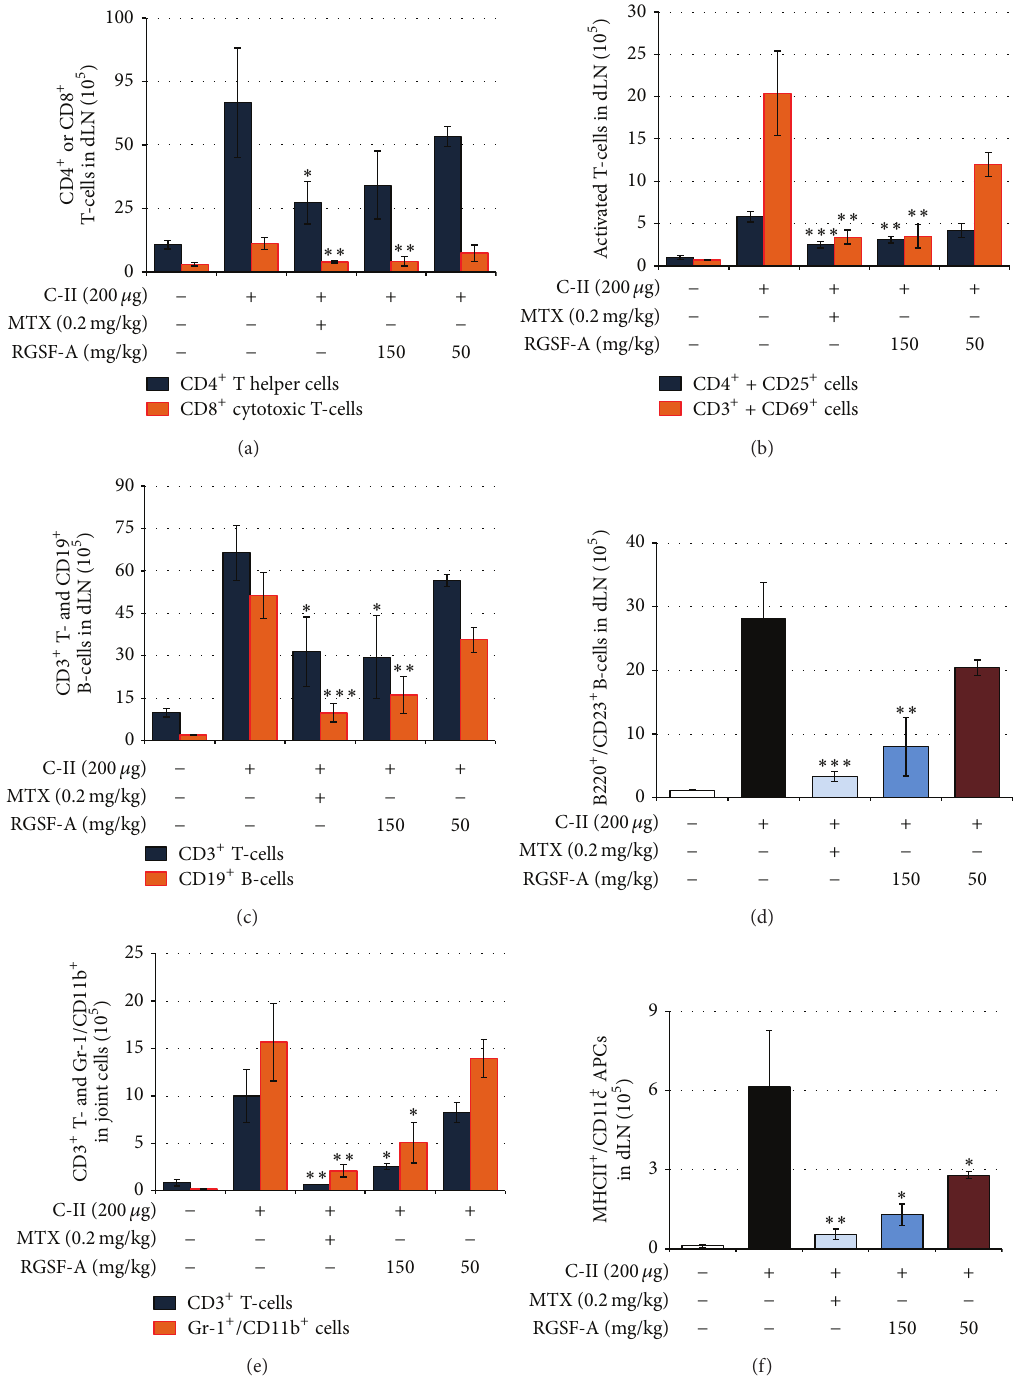
Figure 4: RGSF-A treatment affects CIA immune cell subpopulation activation and colocalization in dLN and joints of CIA mice. Flow cytometry was performed to detect cell surface molecules as indicated in the methods section. (a) CD4 + T helper (black bars) and CD8 + cytotoxic (gray bars) T-lymphocyte subpopulations are depicted. (b) Bar graphs show a relative subpopulation of CD4 + CD25 + double positive T lymphocyte CD4 T-cells (black bars) and CD3 + CD69 + double positive, early T lymphocyte activation marker (gray bars). (c) Relative colocalization of T-lymphocytes expressing CD3 + cell surface marker (black bars) and a subpopulation of B-lymphocytes with CD19 + cell surface markers (gray bars) were analyzed in mice treated with RGSF-A, MTX, or vehicle by flow cytometry. (d) CIA-stimulated B220 + CD23 + doublepositivecellsasmarkerofactiveB-lymphocytewereanalyzed.(e)T-lymphocytesexpressingCD3 + surfacemarkers(black bars) with neutrophils (gray bars) expressing Gr-1 + CD11b + surface markers infiltrated in the joints. (f) Antigen presenting cells expressing MHCII + CD11c + double positive cell surface marker (black bars) were analyzed as cellular infiltrates in dLN. ∗ 𝑃 < 0.05 , ∗∗ 𝑃 < 0.01 , and ∗∗∗ 𝑃 < 0.001 as compared with vehicle treatment; 𝑛 = 6 for each